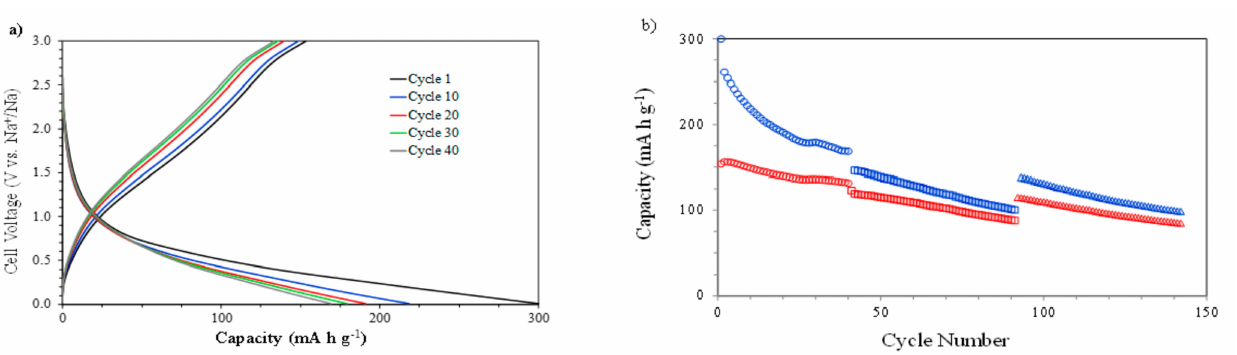
Figure 5. The electrochemical characterization of NiO films at different current intensities: ( a ) discharge–charge profiles (capacity vs. cell voltage) at 1000 mA g − 1 and ( b ) discharge (blue) and charge (red) capacities vs. cycle number at 1000 (o), 1200( (cid:3) ), and 800 ( ∆ ) mA g − 1